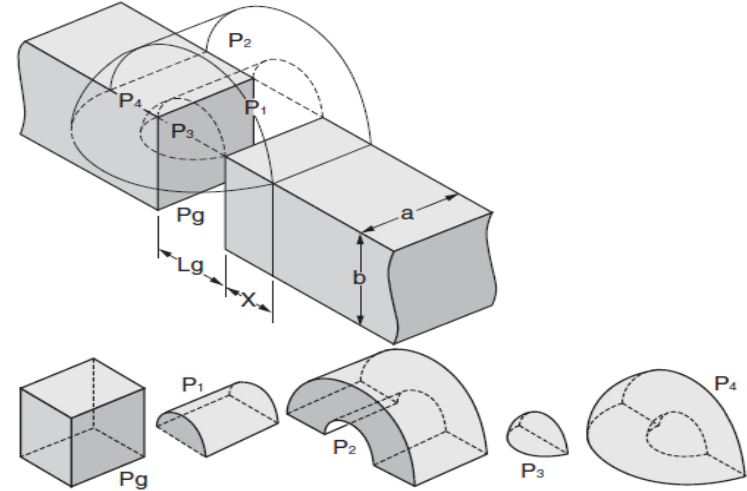
Figure 3. Geometric elements used for the description of the magnetic leakage flux [15].